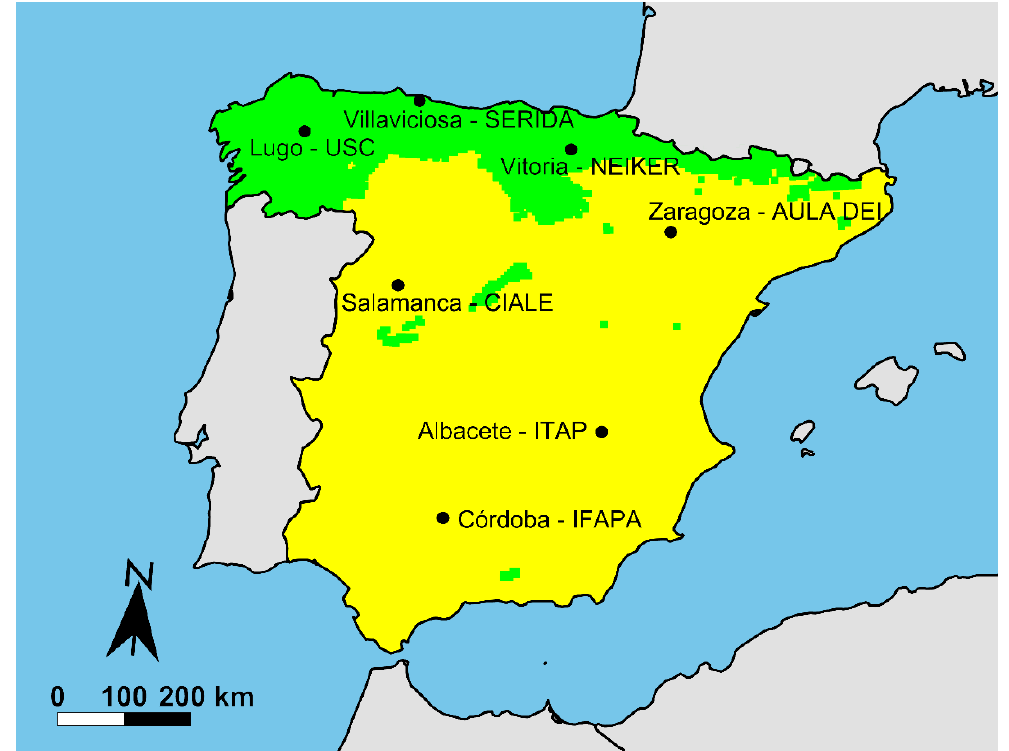
Figure 1. Result of k PAR clustering over the territory of study. The oceanic cluster is represented in green, while the Mediterranean one is in yellow. The locations of the seven stations used for validating the models are also represented. Table 1. Localization of PAR stations.